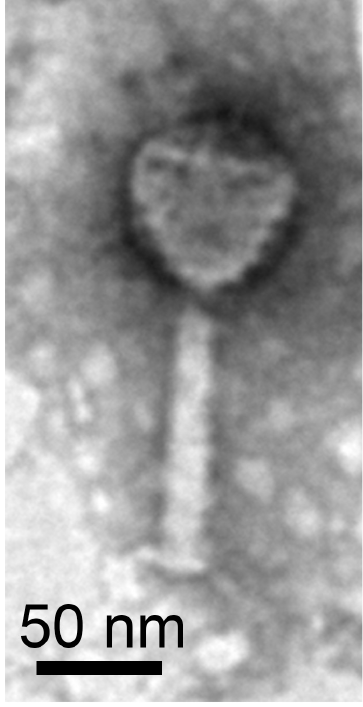
Figure 4. Luteibacter ‐ associated bacteriophage vB_LflM ‐ Pluto.